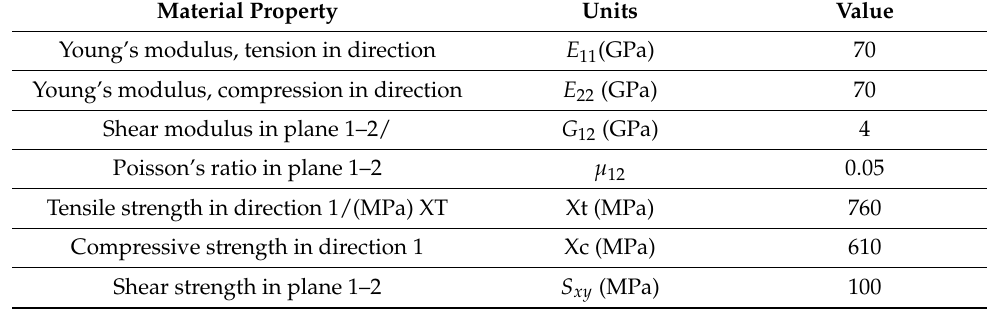
Figure 3. ( a ) stress strain diagram for plies with [0/90°] orientation, where 5 samples were used for repeatability purpose, ( b ) stress–strain diagram for plies with [±45°] orientation, where 4 samples were used for repeatability purpose.